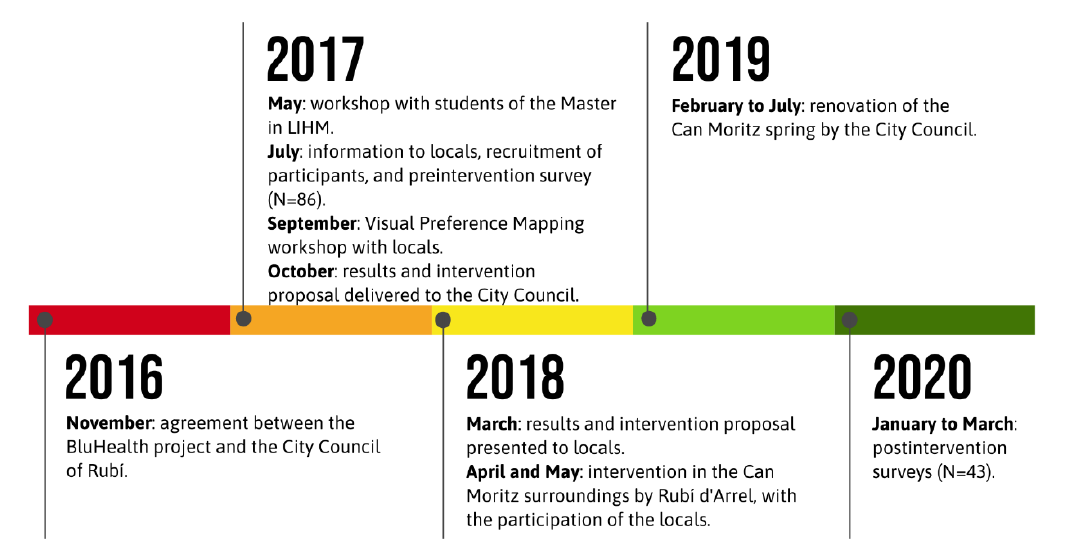
Figure 3. Calendar of the project (intervention and its evaluation).